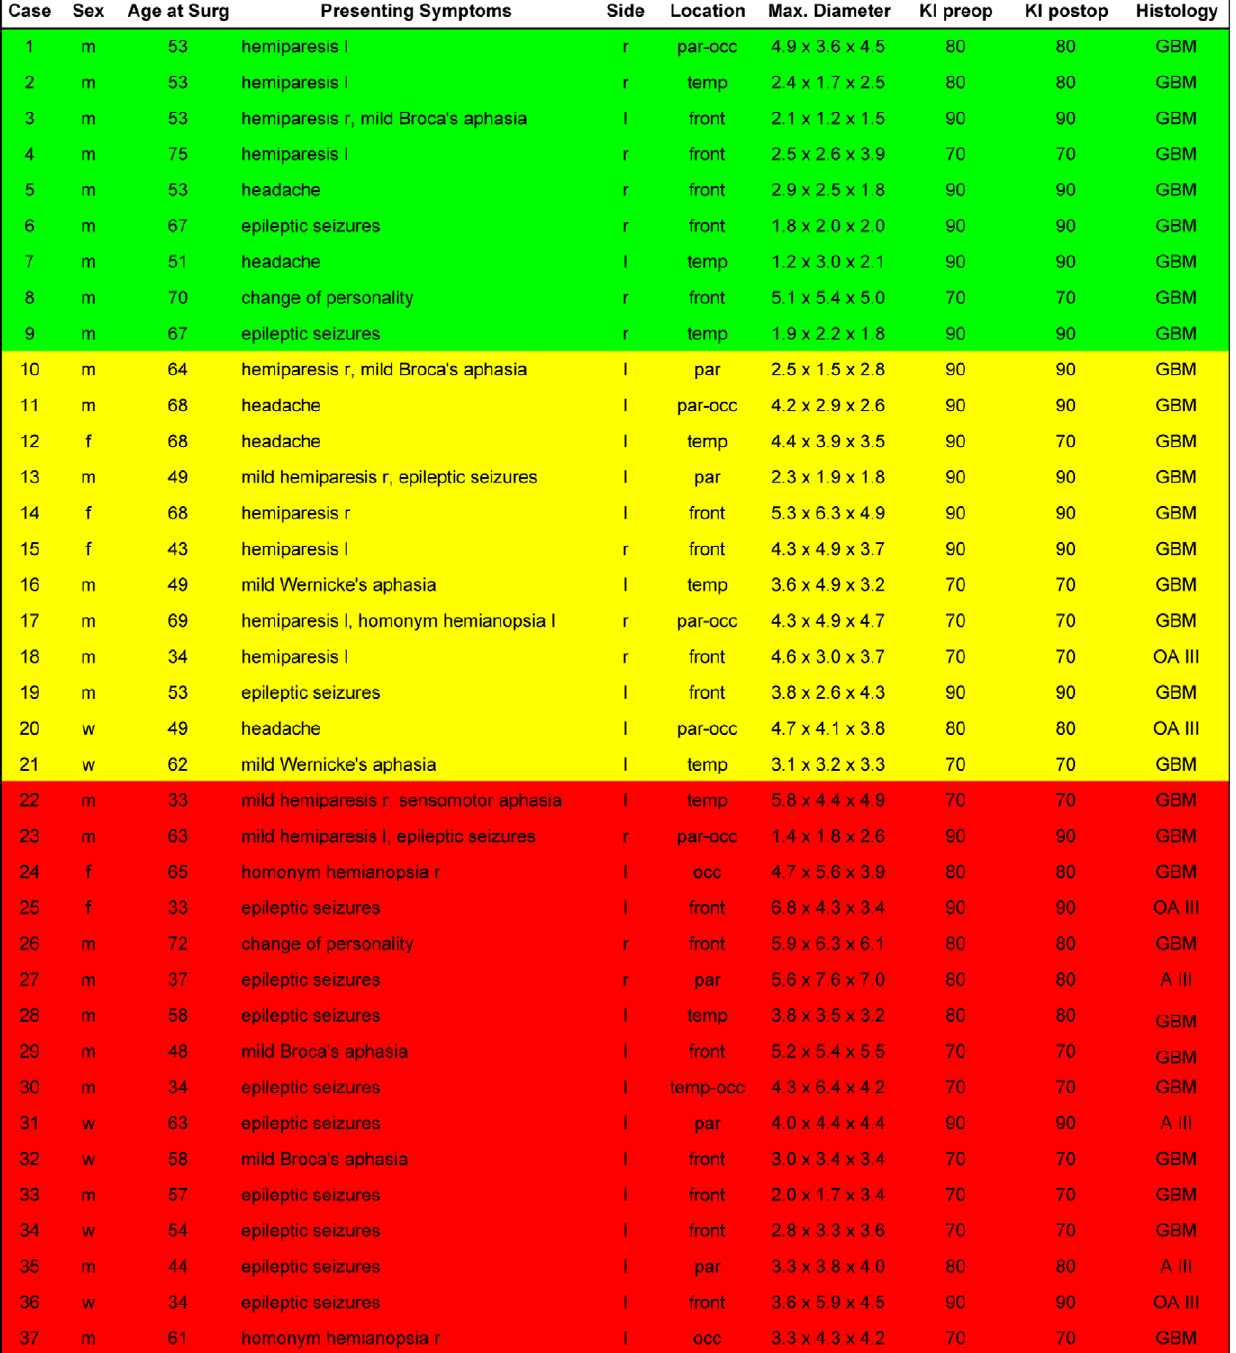
Figure 1. Patient data depicted includes age, sex, presenting symptoms, tumor localization, the maximum dimensions of the tumor, the pre- and postoperative Karnofsky Performance Scale Index (KI) and the Neuropathological diagnosis according to the current WHO Classification System. All included patients had suspected malignant gliomas (WHO grade III or IV), i.e. evidencing contrast